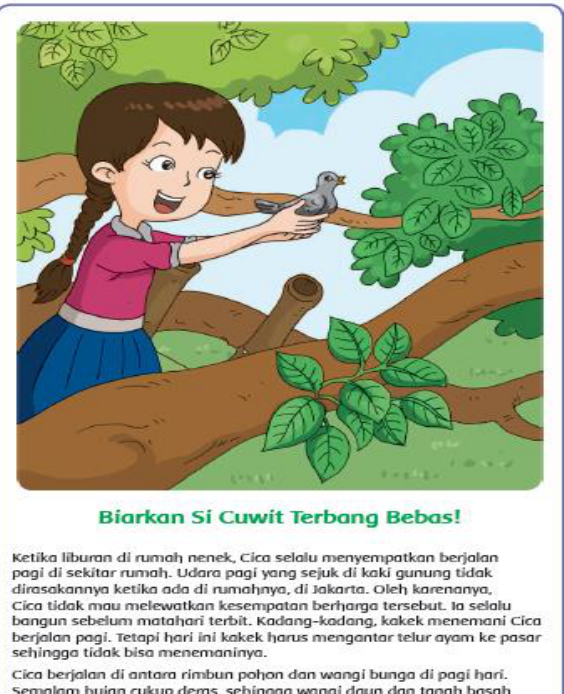
Figure 19: The story let si Cuwit fly